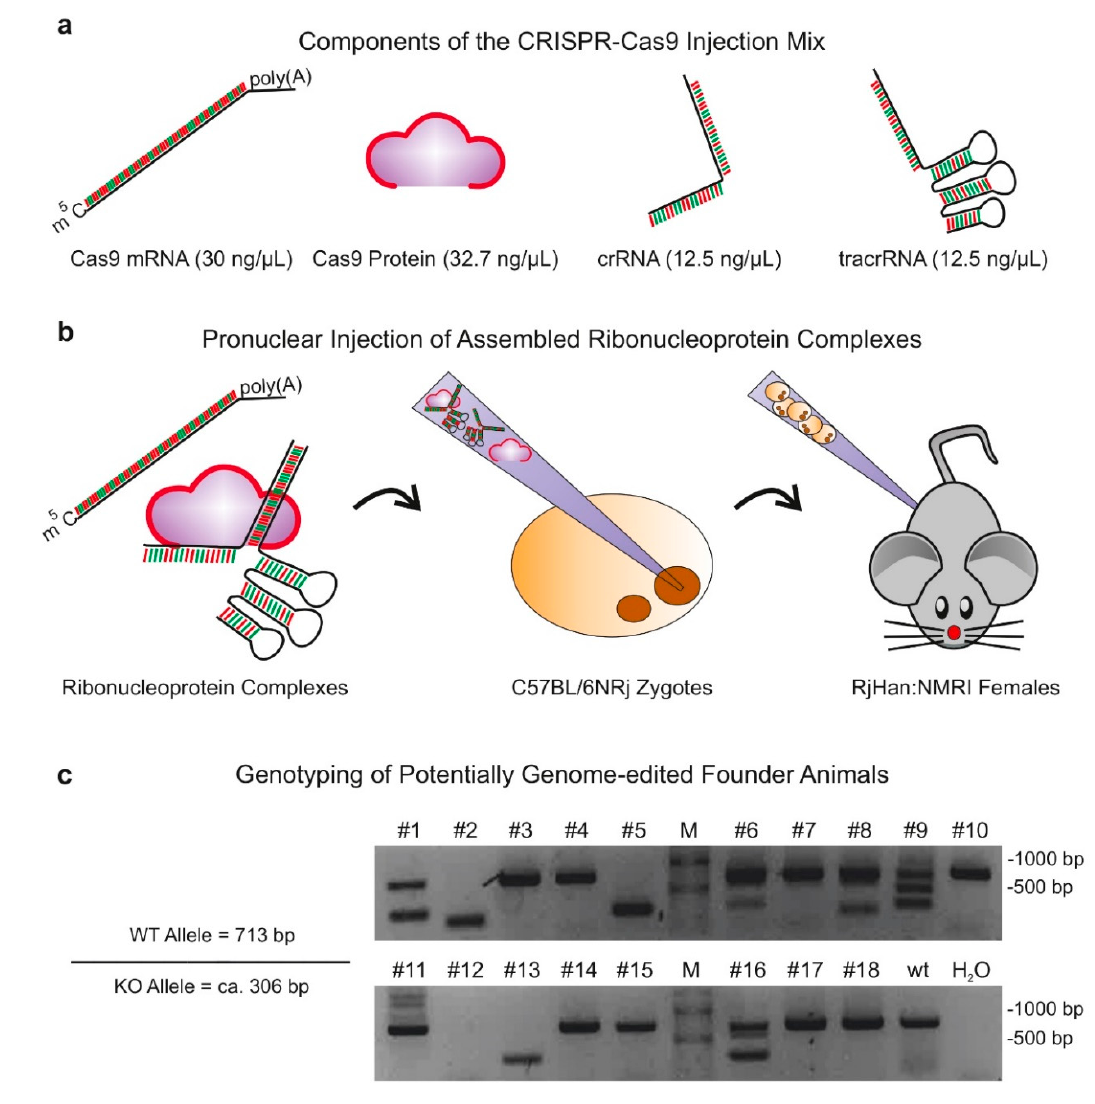
Figure 3. In vivo gene-targeting: Schematic representation of the experimental approach to generate in vivo mouse models, depicting the ( a ) composition of the CRISPR/Cas9 injection mix, containing Cas9 mRNA, Cas9 protein as well as the gRNA components trans-activating CRISPR RNA (tracrRNA) and crRNA; ( b ) pronuclear microinjection of assembled ribonucleoprotein complexes into C57BL/6NRj zygotes and embryo transfer of 2-cell stage embryos into pseudopregnant RjHan:NMRI females. Concentrations of the injection components are indicated in the panel. ( c ) Agarose gel depicting genotyping PCR reactions with primers flanking the targeted genomic region using genomic DNA isolated from 18 individual founder mice, which have been obtained by pronuclear microinjection of CRISPR/Cas9 components. M, marker; wt C57BL/6 wildtype control mouse; H 2 O, no template control PCR.